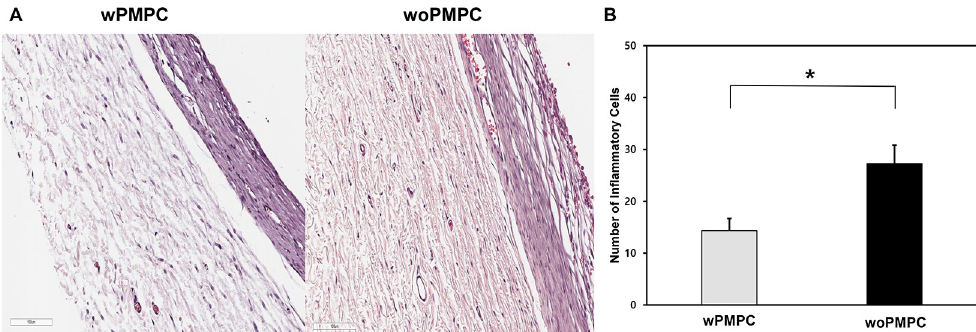
Fig 5. Comparison of inflammatory response in tissues surrounding the implant area after Ahmed glaucoma valve implantation. (A) 200 × magnified images of H&E staining showed numerous inflammatory cells of each eye in the same rabbit. Scale bars: 100 μ m. (B) The number of inflammatory cells around the PMPC-coated AGV was significantly smaller than that around the PMPC-uncoated AGV ( p = 0.037). Data are shown as the mean ± standard deviation for each group. wPMPC, Ahmed glaucoma valve coated with PMPC; woPMPC, Ahmed glaucoma valve without PMPC-coating.